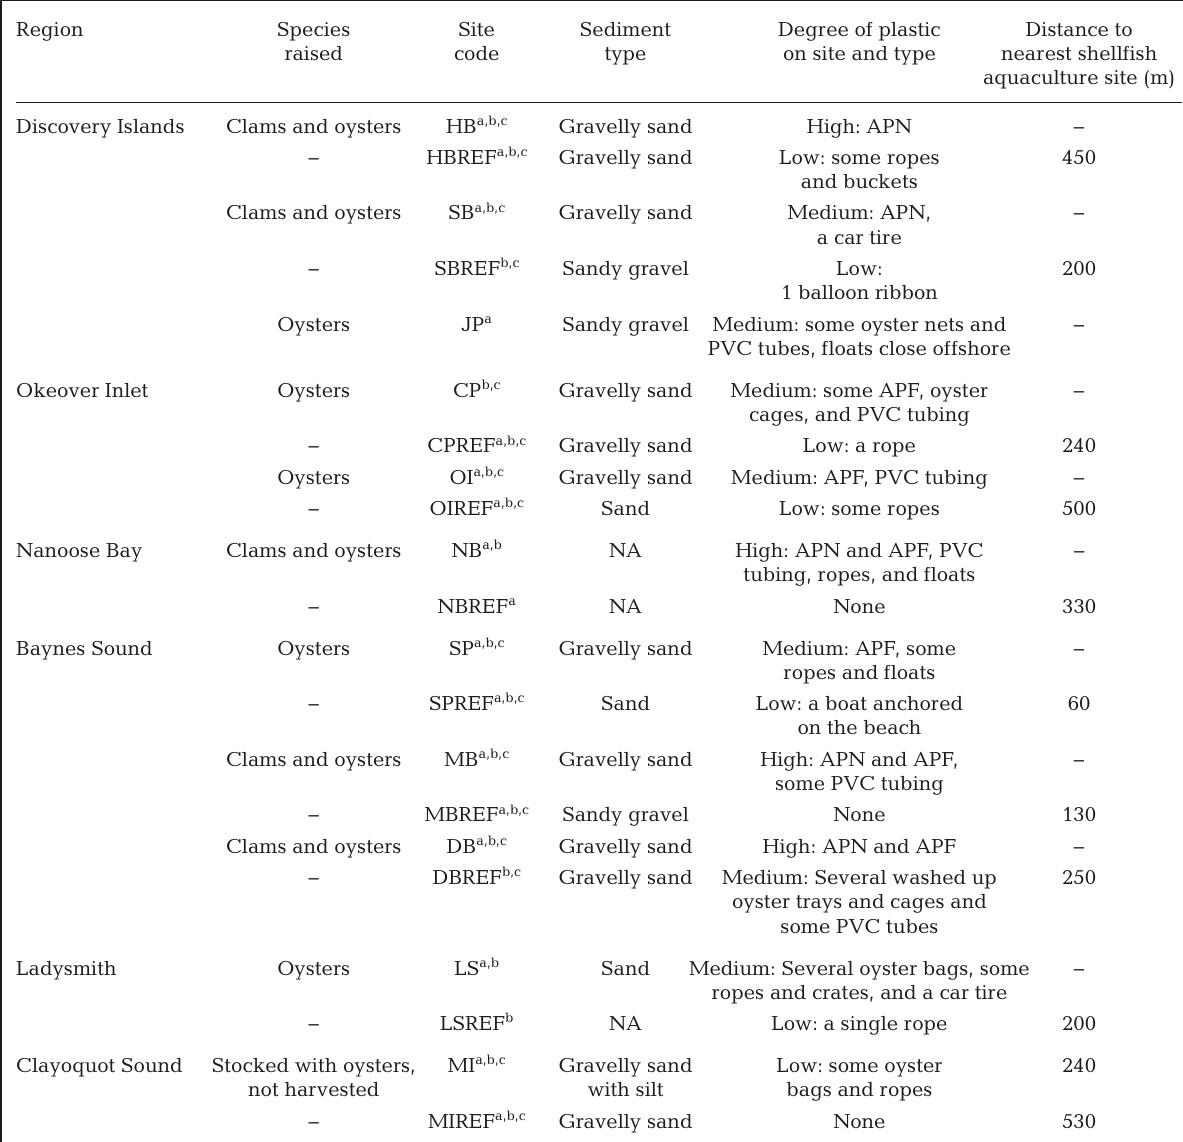
Table 1. Information on the 21 field sites, including region, species raised, site code used in this paper, sediment type (as deter- mined from average grain-size class proportions from all sediment cores taken at each site and classified according to